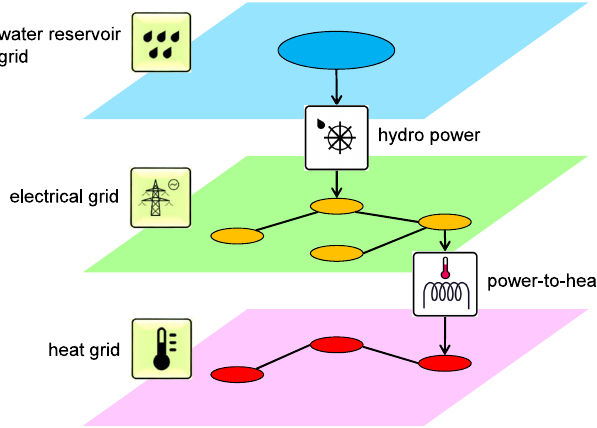
Figure 1. Network structure. The three layers represent different grids, the circles on the layers represent nodes and the arcs connecting the nodes represent lines. Hydro power and power-to-heat facilities are examples of units converting energy between the